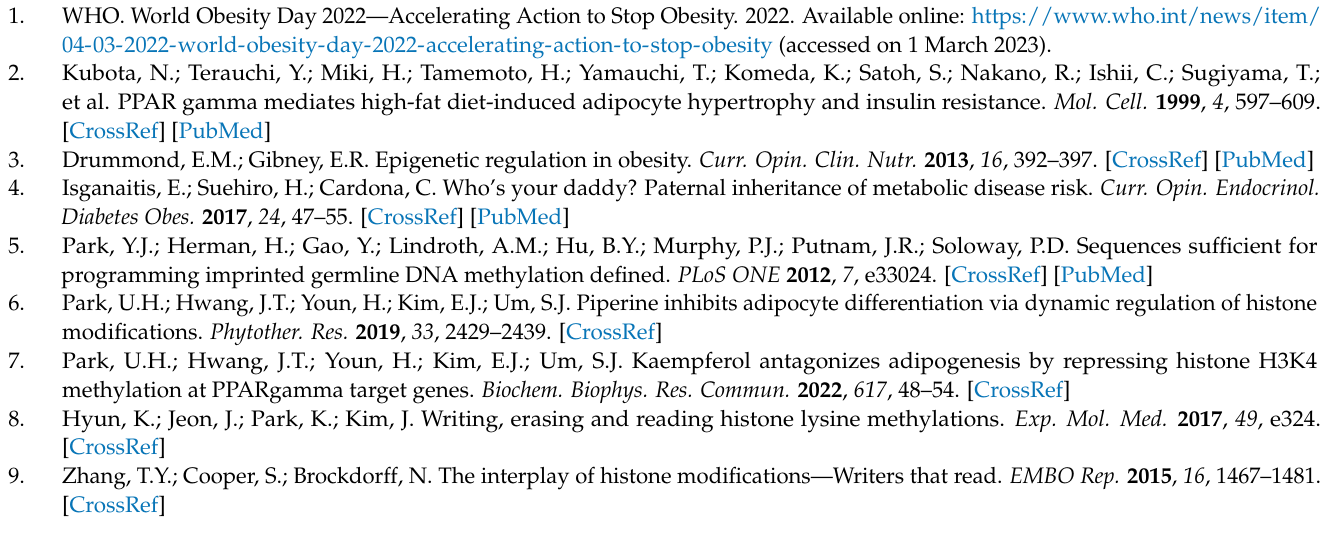
Supplementary Figure S3: Effect of shikonin on rosiglitazone-induced activation of the PPAR γ target genes. Supplementary Figure S4: Epigenetic regulation of PPAR γ target genes by